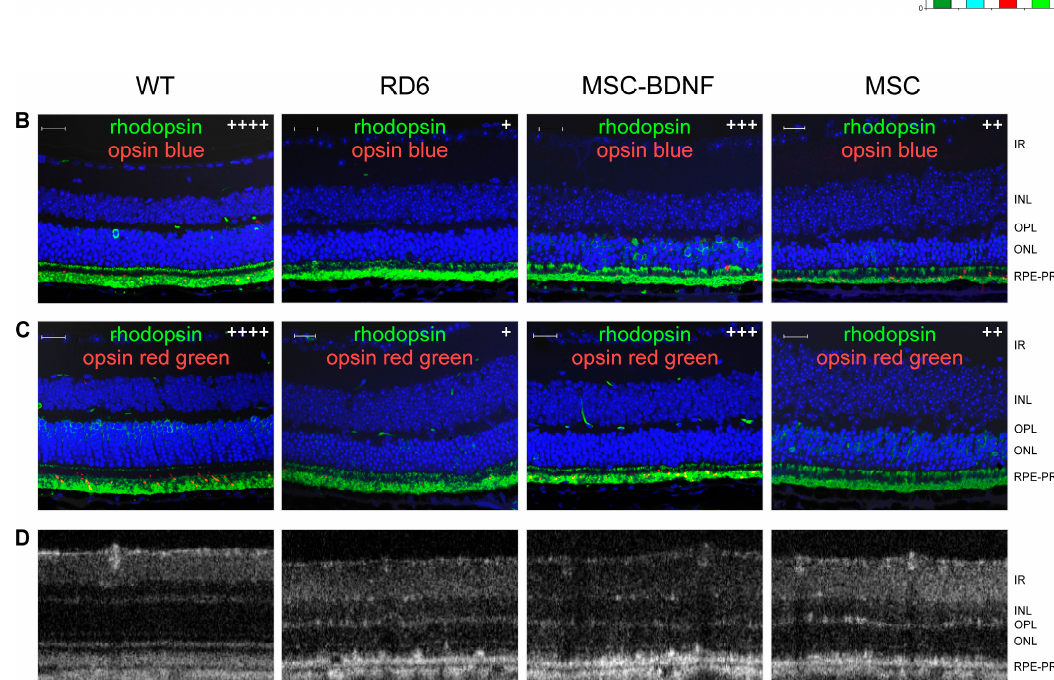
Figure 6. Effects of in vivo experimental therapy with genetically transduced MSC-BDNF and unmodified MSC on the retinal function and OCT-based retinal morphology at three months post transplantation compared to rd6 mice with no treatment and WT mice. The representative ERG responses recorded after cell injection are shown ( A ). The b-wave amplitude measurements are presented as the mean ± SD. Immunohistofluorescence co-staining for rhodopsin (green) with